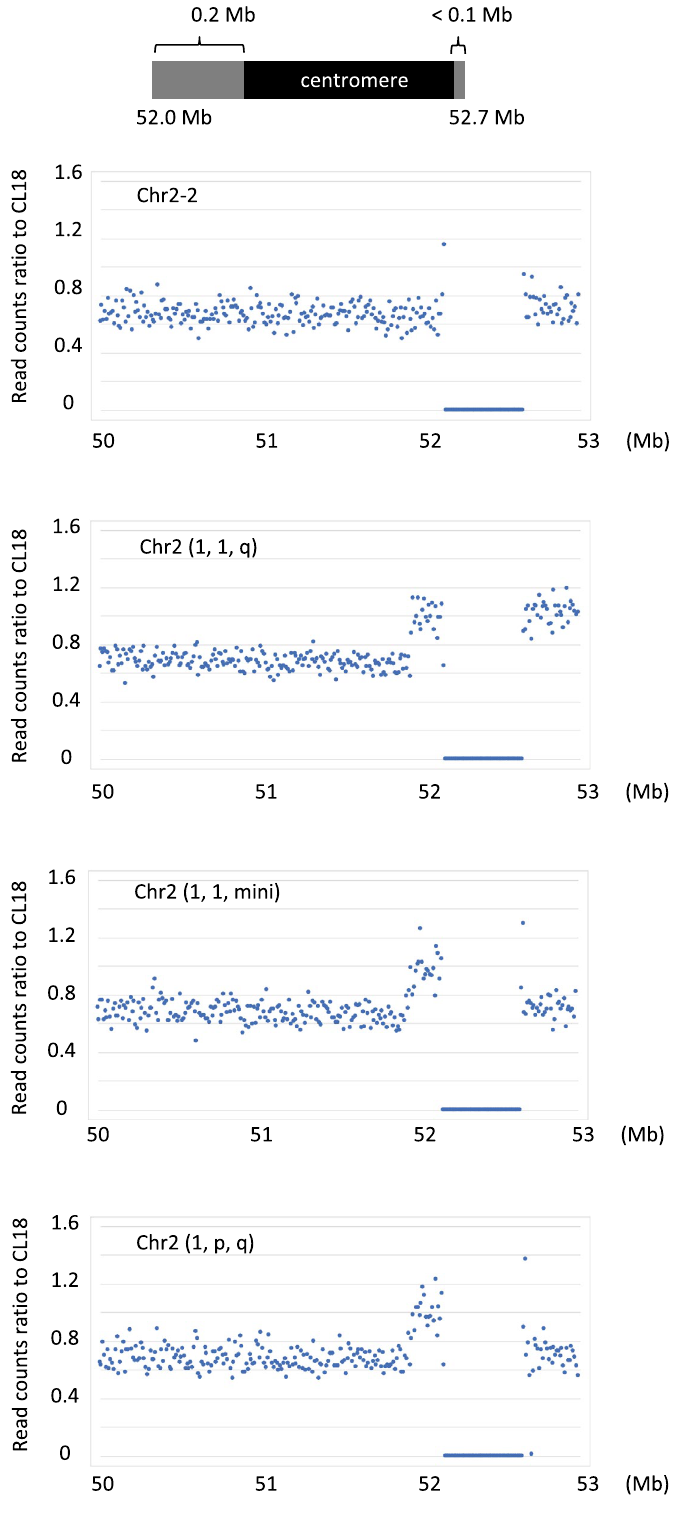
Figure 4. Copy number variation near the centromere of chromosome 2. The number of sequence reads mapped on the indicated positions of chromosome 2 (every 10 kb) was normalized by those of chromosome 1. This score of each strain was further normalized by that of CL18 cells. Position 52.2–52.7 Mb corresponds centromere of chromosome